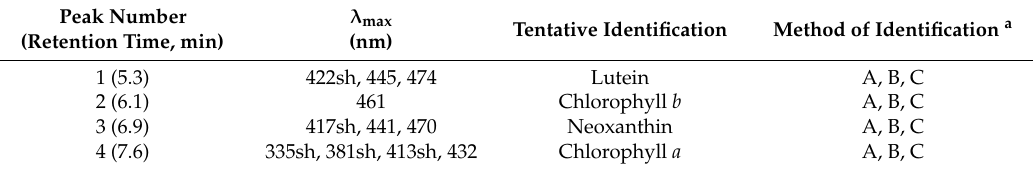
Table 5. Identification of individual carotenoids and chlorophylls in broccoli sprouts. λ max Peak Number Tentative Identification Method of Identification a (Retention Time, min) (nm)